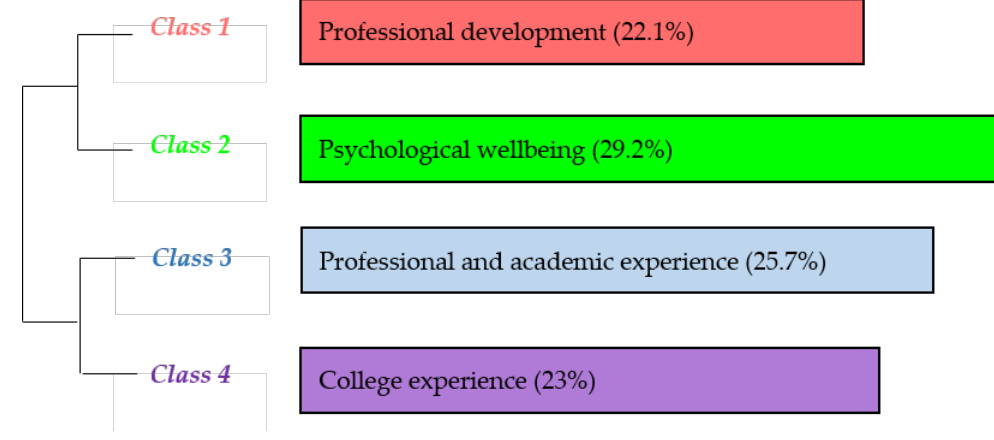
Figure 3. Dendrogram of the preinterview classes.